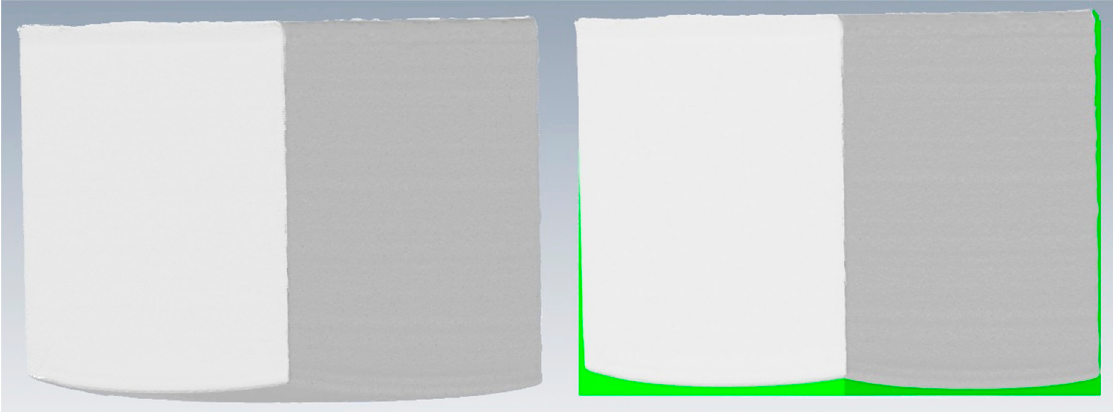
Figure 12. ( Left ): scanned object. ( Right ): Comparison with resized theoretical object. Green parts indicate differences. Table 5. Results of the differences between the theoretical and real volume of the printouts.